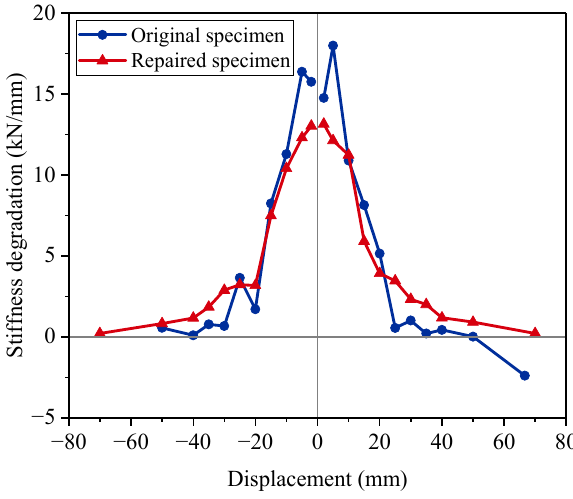
Figure 14. Stiffness